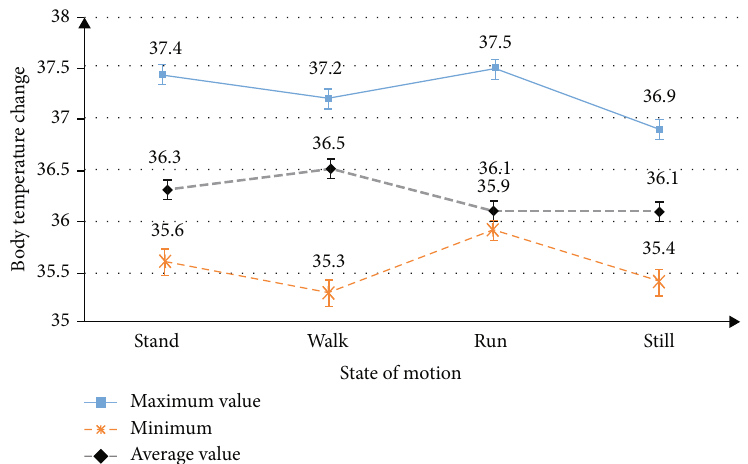
Figure 8: Temperature changes in di ff erent states.